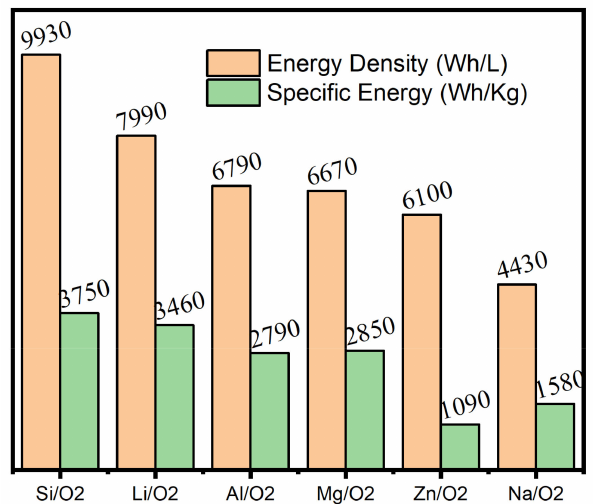
Figure 7. Theoretical energy density and specific energy (including oxygen) of commonly researched metal–air batteries. Adapted from [23]. Copyright (2021) MDPI. This article is an open access article distributed under the terms and conditions of the Creative Commons Attribution (CC BY)